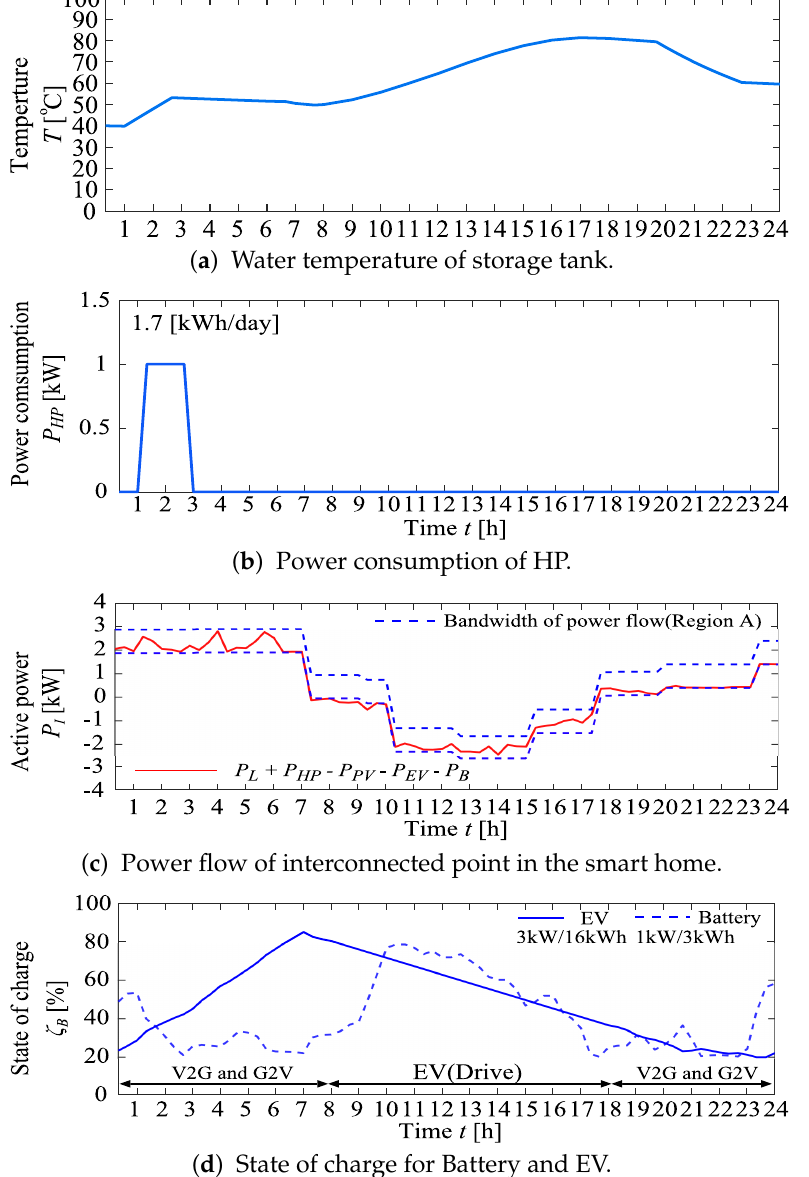
Figure 10. Simulation results with considering re-forecast and re-plan, without considering uncertainties on a fair day (Case